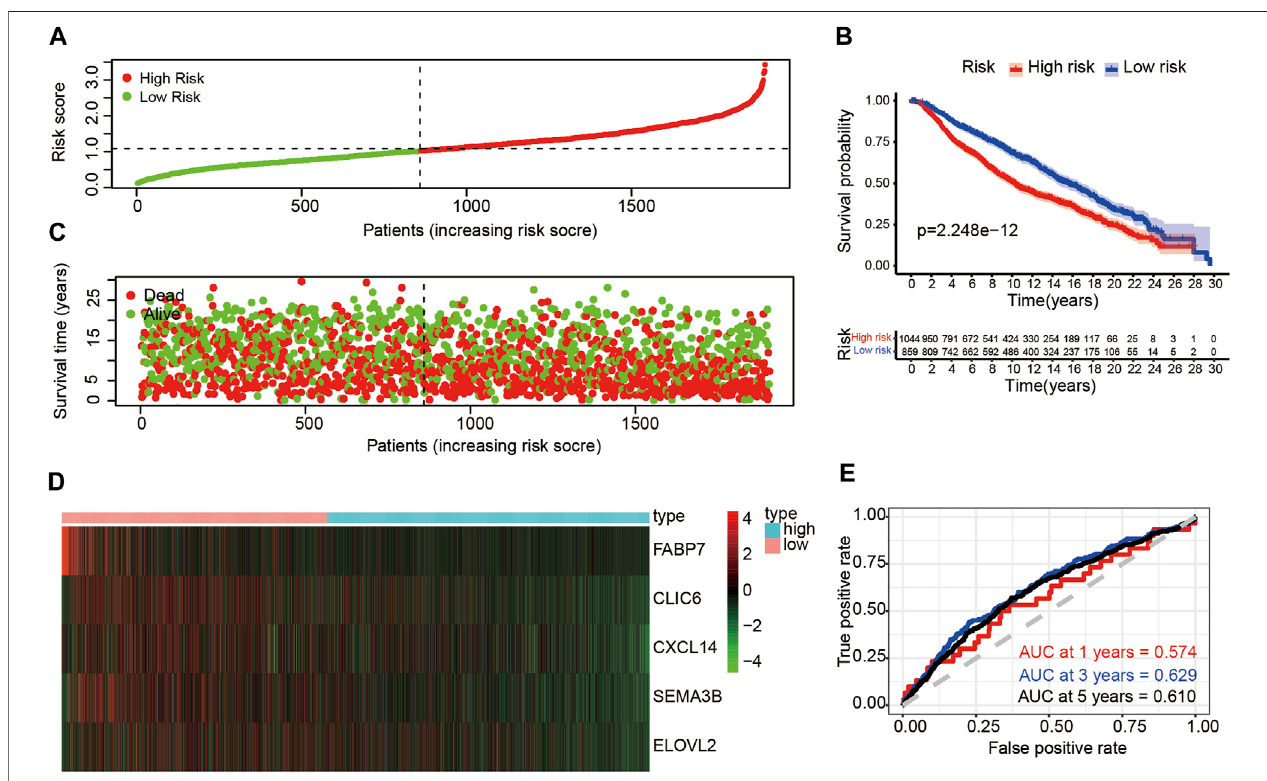
FIGURE 6 | Risk analysis and overall survival of DE-IRGs in the test set (A) The risk score strati fi ed the breast cancer patients into high-risk groups ( “ High ” red line) and low-riskgroups( “ Low ” greenline) (B) Kaplan-Meiersurvivalcurves compared survivalprobabilitybetweenthehigh-riskgroupsand low-riskgroup. (C) Survivaltime and survival status ofpatientsin breast cancer compared between high-risk groups and low-riskgroups. Green plots foralive, red plots for dead (D) Heatmapindicated expression of the fi ve DE-IRGs in breast cancer. Blue colorrepresents high group, while pink color represents lowgroup. (E) Time-dependent ROC curves for DE- IRGs model to predict patient